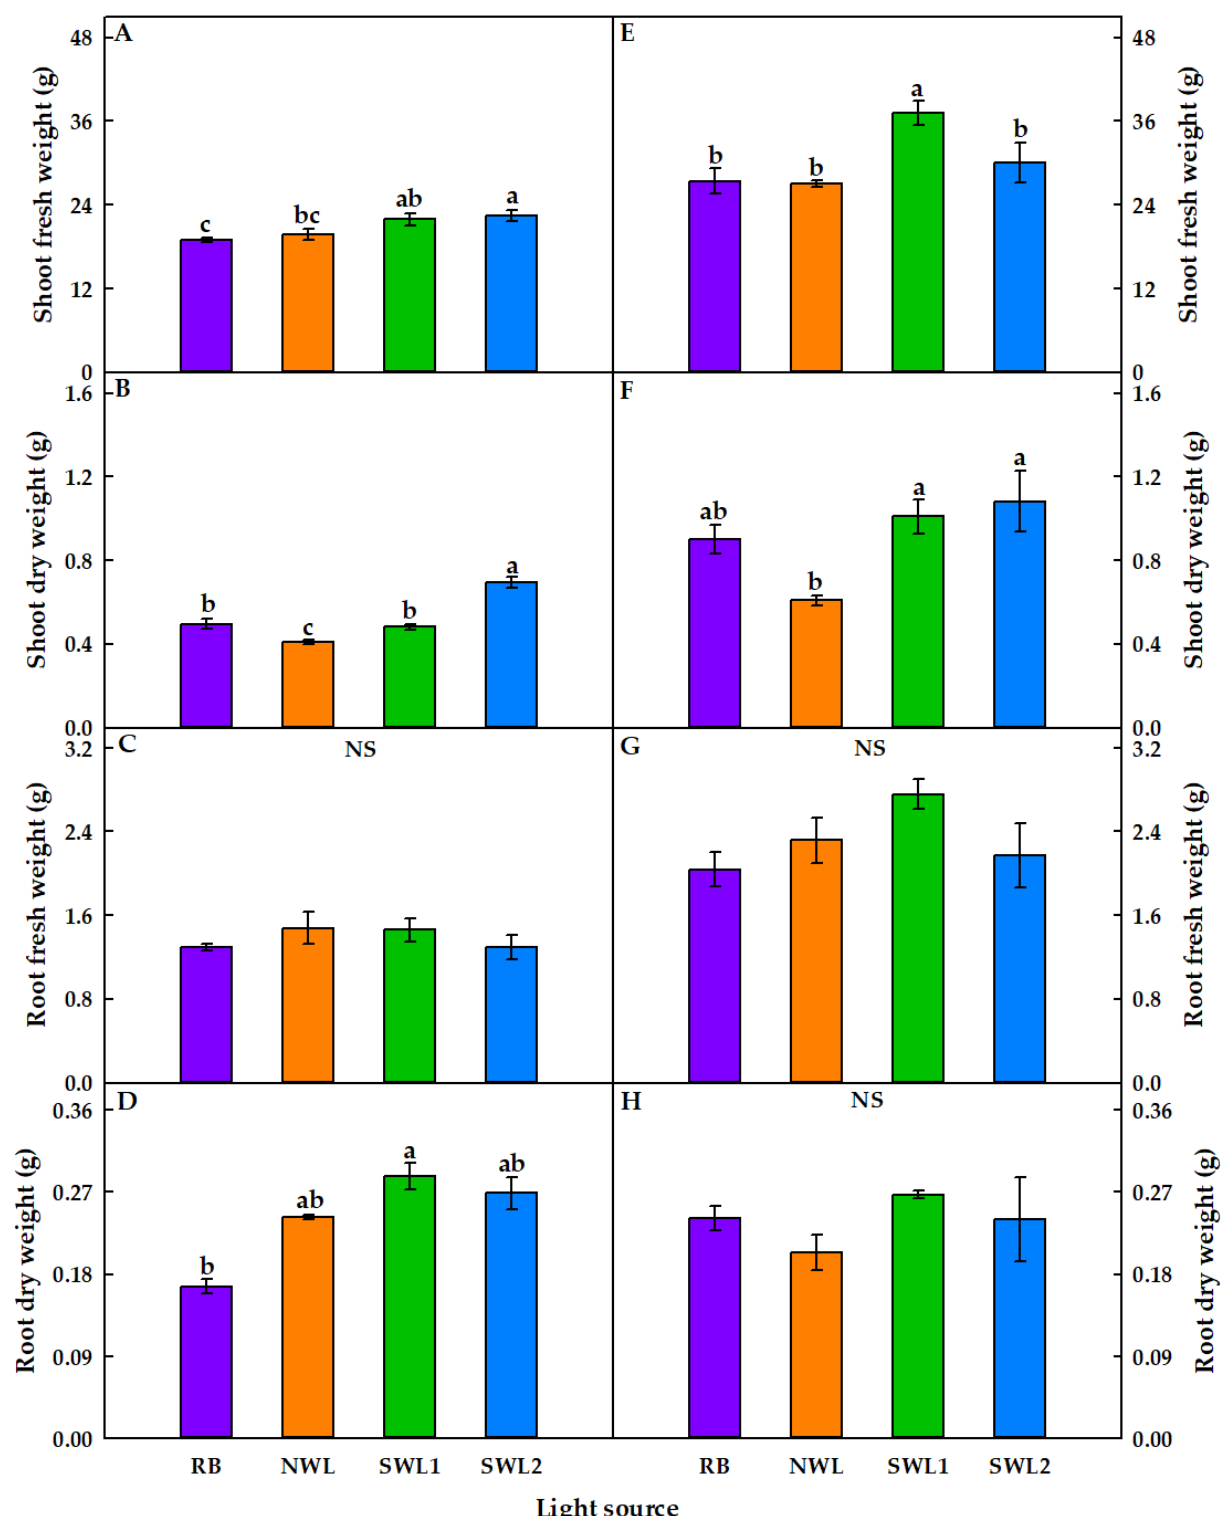
Figure 7. Shoot and root fresh and dry weights of butterhead lettuce ( A – D ) and romaine lettuce ( E – H ) plants grown under various light sources with the same PPFD after 4 weeks of transplanting. Different letters indicate significant difference at p < 0.05 ( n = 4).